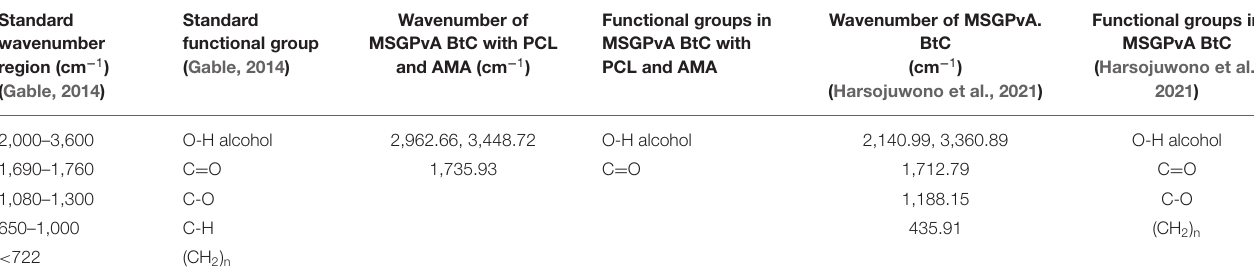
TABLE 1 | Wavenumbers and functional groups in MSGPvA BtC with PCL and AMA and MSGPvA BtC (Harsojuwono et al., 2021). Standard